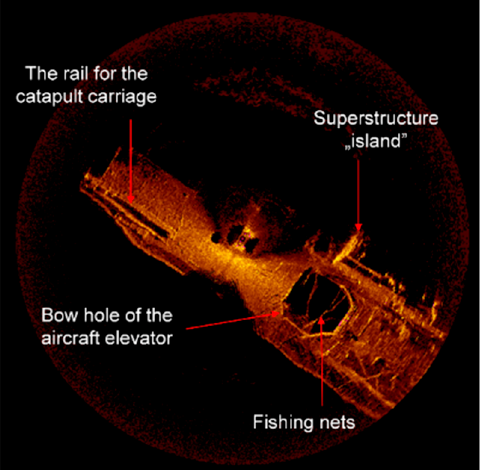
Figure 21. Sonar imagery of the bow part of the shipwreck with a distinctive airlift opening.